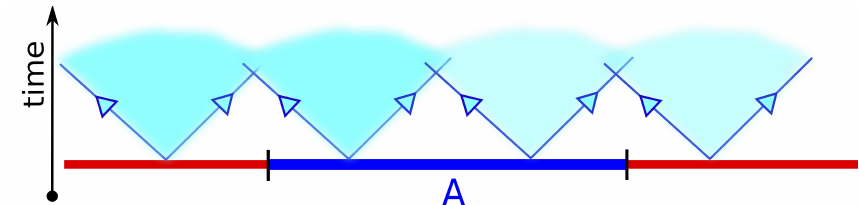
Figure 1: Quasiparticle picture for the spreading of entanglement. The initial state (at time t = 0) acts as a source of pairs of quasiparticles produced homogeneously throughout the system. After being produced, the quasiparticles separate ballistically moving with constant momentum-dependent velocity and spreading the entangle-